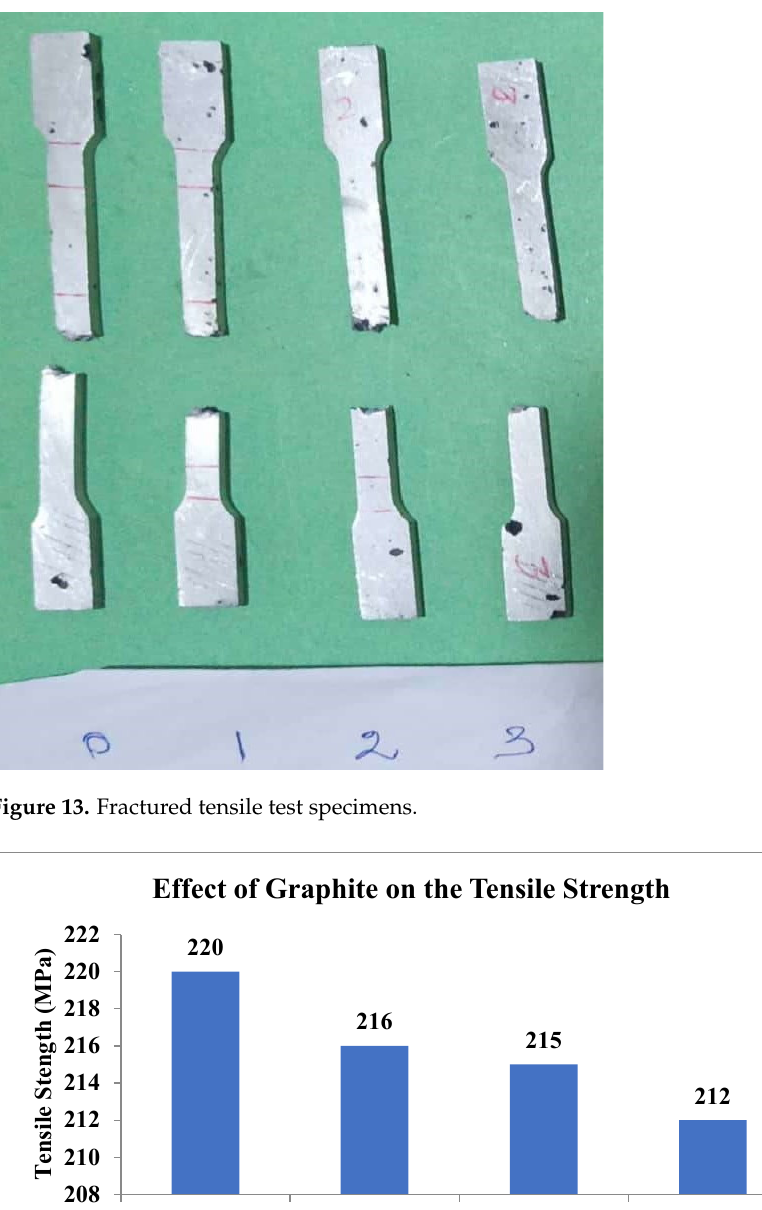
Figure 14. Effect of graphite on the tensile strength of composites.